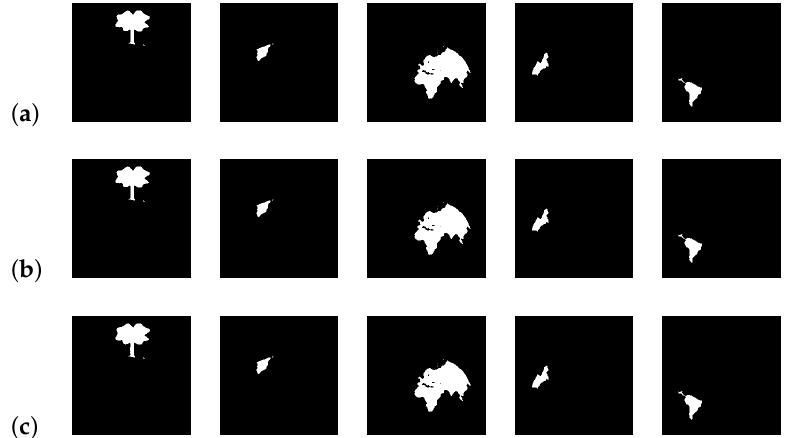
Figure 24. Extracted regions for different values of k and d ( a ) k = 3 and d = 30; ( b ) k = 3 and d = 40;